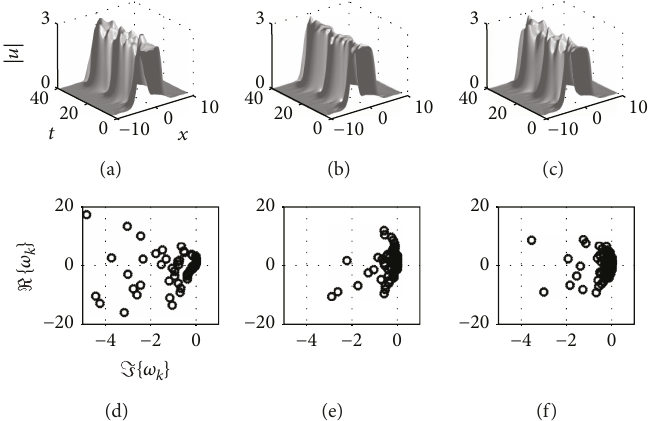
Figure 7: Reconstruction of the CQGLE dynamics of Figure 6(a) using a rank r = 60 expansion. Shown are (a) a standard DMD approximation g x , (b) the CQGLE motivated g x , and (c) a quartic observable g x . The Koopman spectra for each observable DMD 3 4 are demonstrated in (d), (e), and (f) which accompany the observables of (a), (b), and (c), respectively. Note that the observable g produces spectra which are most approximately purely imaginary which is expected of the periodic evolution. A visual inspection shows that the observable g x produces the best 3